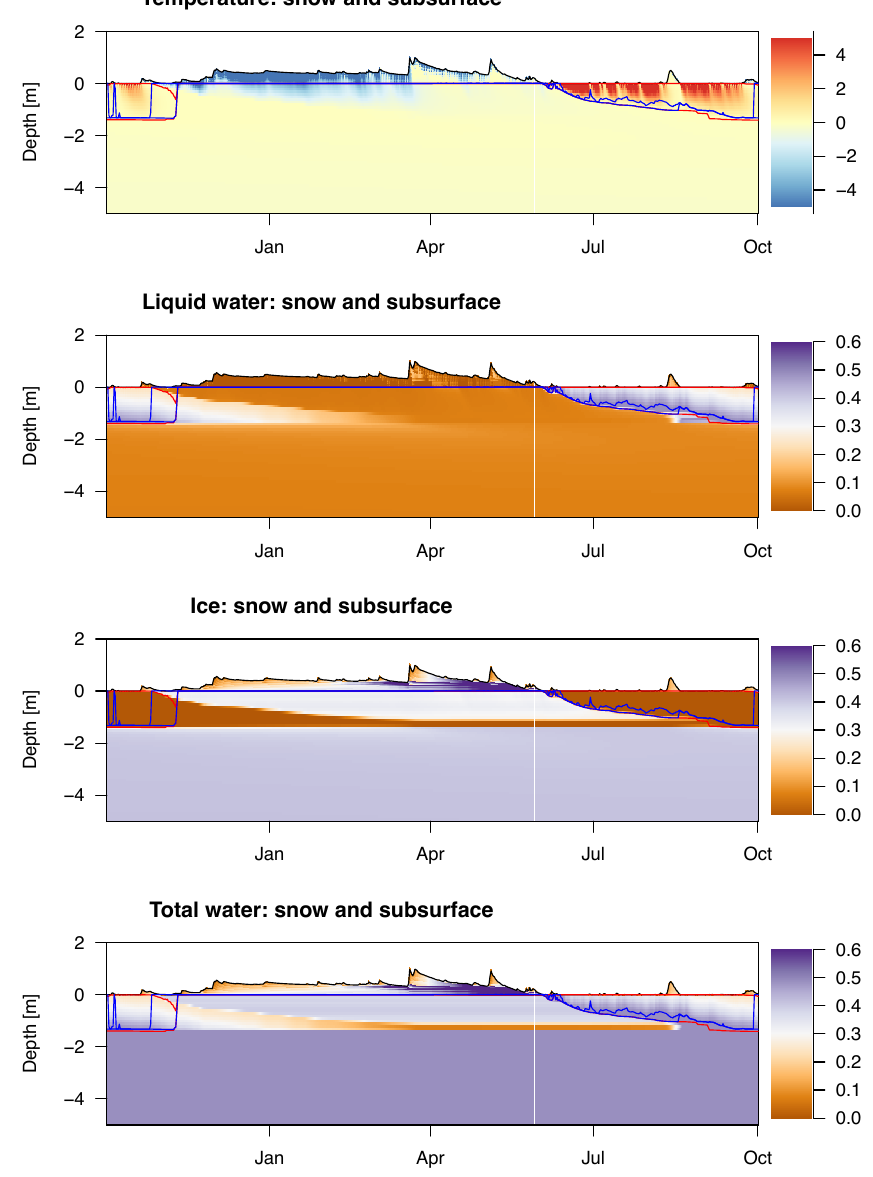
Figure 7. Time evolution of temperature, and liquid, solid, and total water content for soil and snow at Point 1, as shown in Fig. 4, for the simulation for the 5 ◦ topography 3-D. The blue line indicates the water table, while the lower and upper borders of the thawed layer are shown in red. Negative depths correspond to soil, and positive depths to the snow